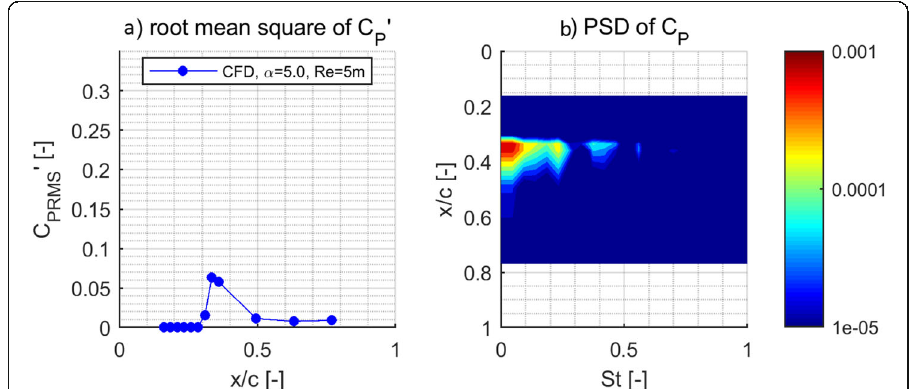
Fig. 7 Computed C PRMS ’ ( a ) and PSD ( b ) at η = 0.6 for α =